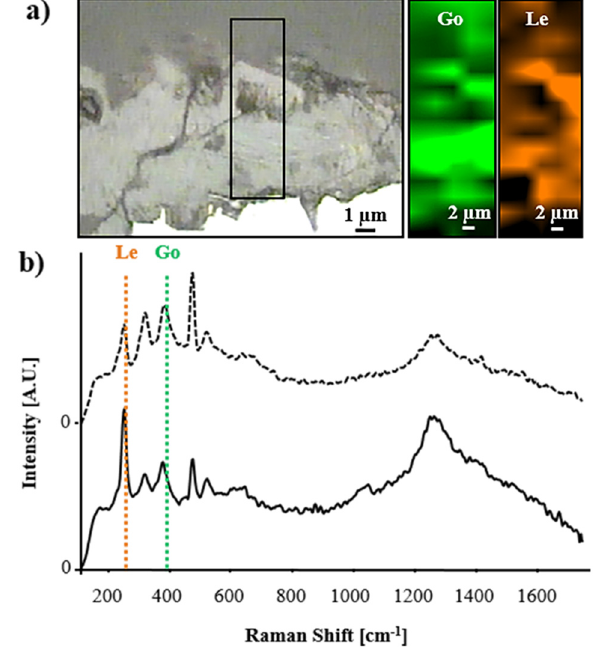
Figure 5. Molecular mapping performed by Raman spectroscopy on untreated coupons. ( a ) From left to right, a microscopic image with a square box indicating the analyzed area and chemical maps of goethite (Go) and lepidocrocite (Le). ( b ) Representative Raman spectrum of a mixture of lepidocrocite and goethite with the corresponding spectral regions selected for the elaboration of the respective chemical maps of lepidocrocite (region labeled “Le” with orange dashed lines) and goethite (region labeled “Go” with green dashed lines).